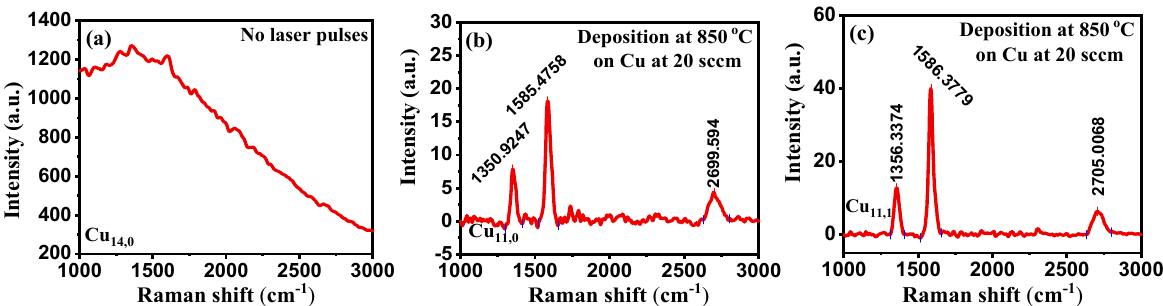
Figure 6. ( a − c ) Raman data plots showing the effect of: ( a ) no laser pulses; ( b ) laser incident spot; ( c ) laser non-incident spot on PyC deposition.